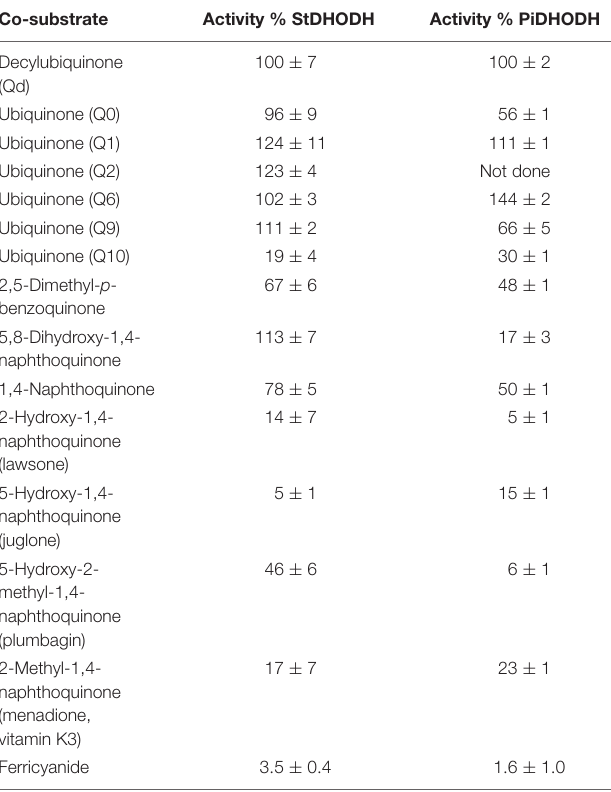
TABLE 2 | Activities of StDHODH and PiDHODH with alternative electron acceptors. Co-substrate